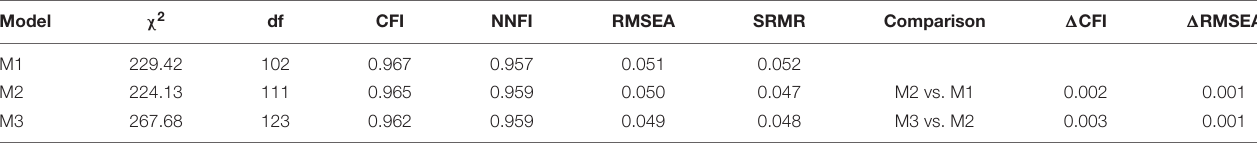
TABLE 1 | Fit indices for measurement invariance across gender. Model χ 2 df CFI NNFI RMSEA SRMR Comparison (cid:49) CFI (cid:49) RMSEA